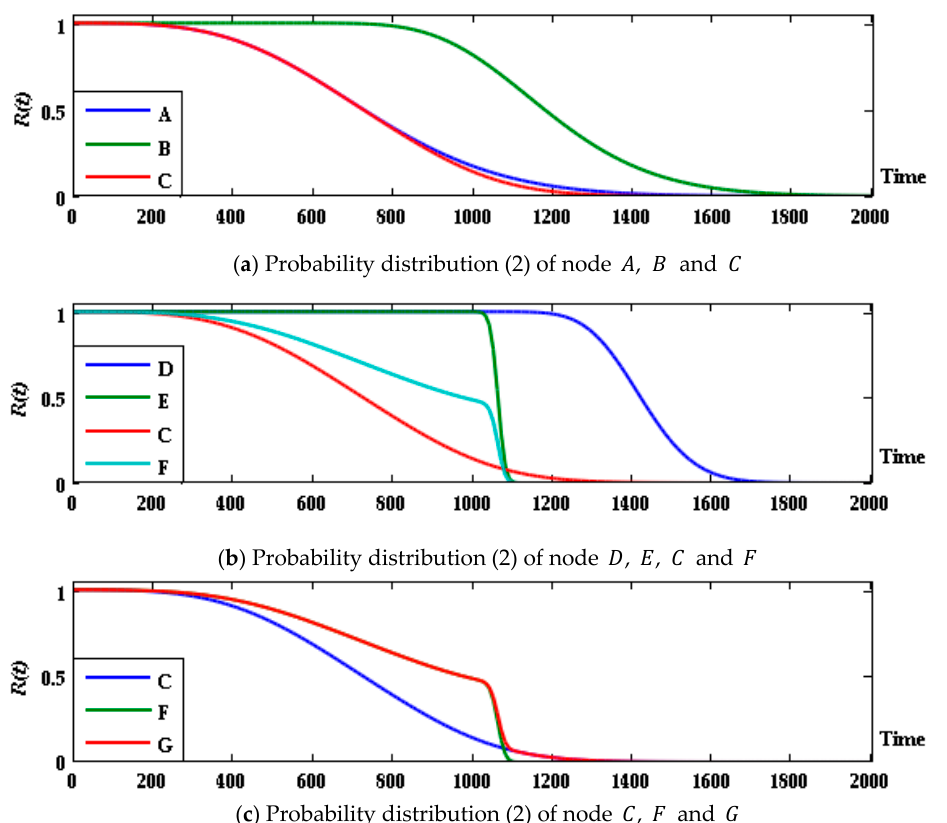
Figure 10. Probability distribution (2) of parent and child nodes at state (cid:1844) for (cid:1833) system group. Compared to the predicted result above, a system whose devices are all in degradation failure mode has a low probability of staying intact at 1030 h, specifically, only 0.622. However, the state probability predicted above at 1030 h is 0.712, and the working state was maintained with a probability of 0.46 until 1200 h. With a probability threshold of 0.45, the remaining life of the system will be less than 1064 h. The main reason for the change of system state is subsystem (cid:1829) , in which the performance parameter of device (cid:1827) follows the Gamma degradation process (Figure 11). The probability of device (cid:1827) to be at state 2 is reduced to 0.5224 at 1000 h, making the system state significantly degraded; after this prediction point, the performance degradation of device (cid:1831) in subsystem (cid:1832) is deteriorated, and the system fails at a faster rate. On one hand, subsystem (cid:1829) has direct effect on the state of system (cid:1833) . On the other hand, the state of (cid:1833) is indirectly affected through the correlation with subsystem (cid:1832) . Therefore, the degradation rate of a system state after integration is faster.